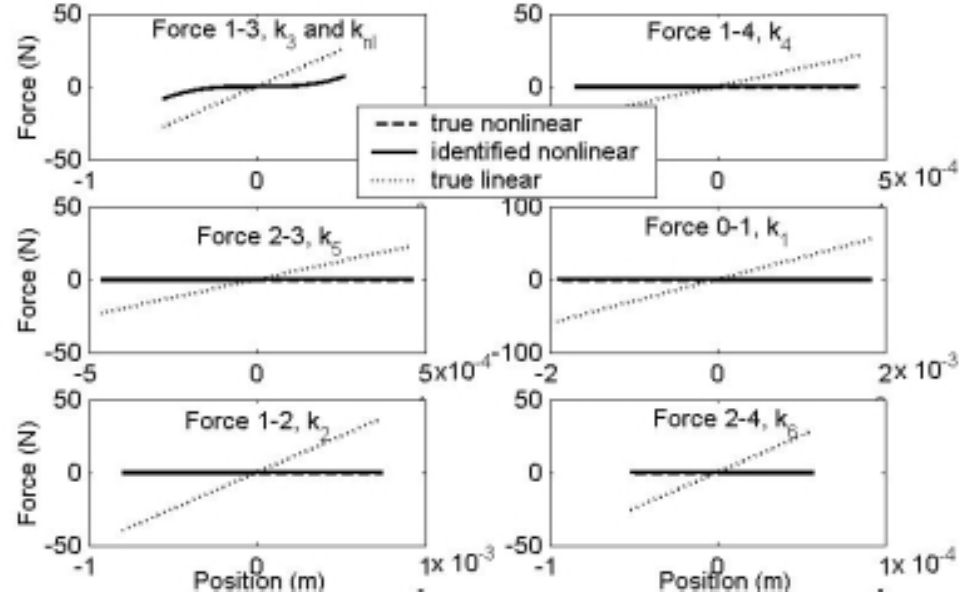
Fig. 5. Stiffness characteristics among the four masses: true nonlinear (dashed line), NSI estimate (solid line) and true linear (dotted line).